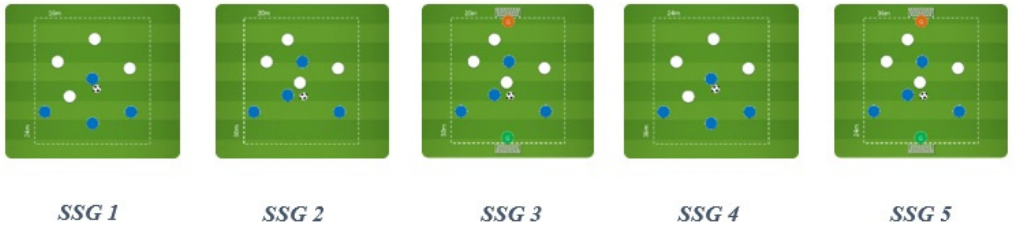
4 of 12 Table 1. Small ‐ sided games performed with different conditions. Tasks